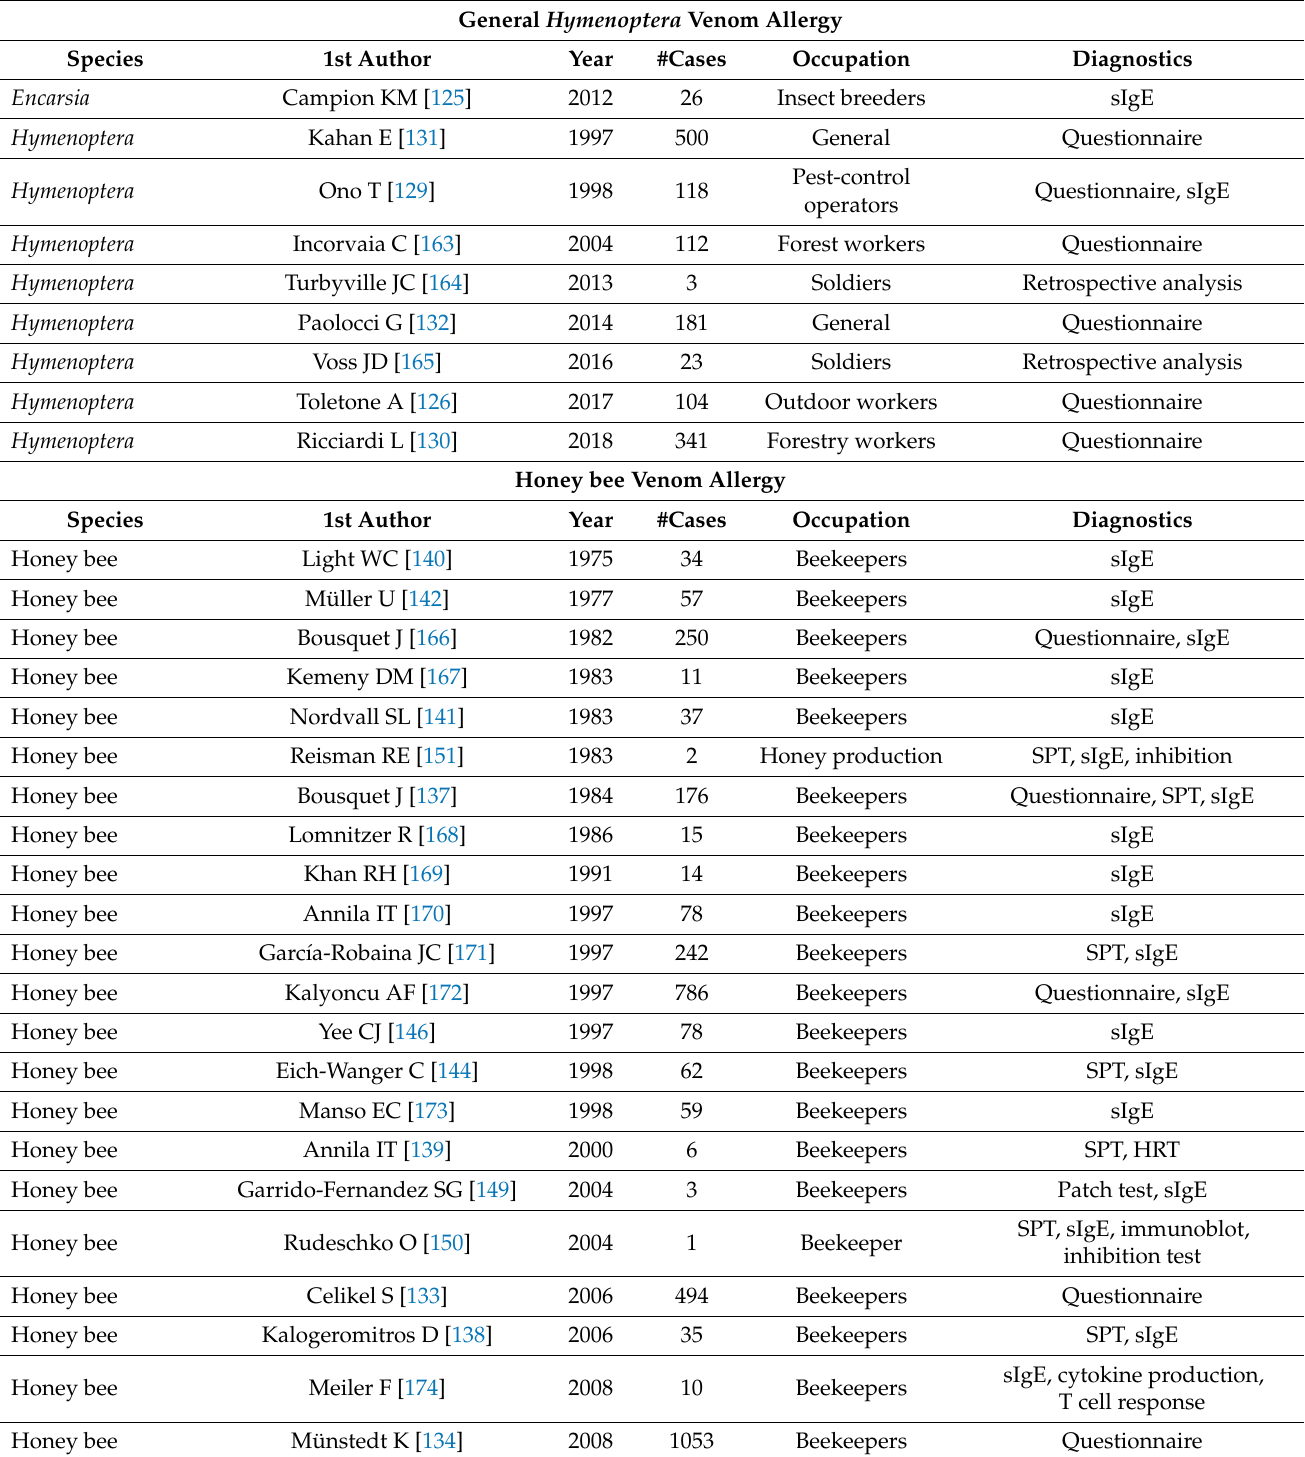
Table 7. Hymenoptera venom